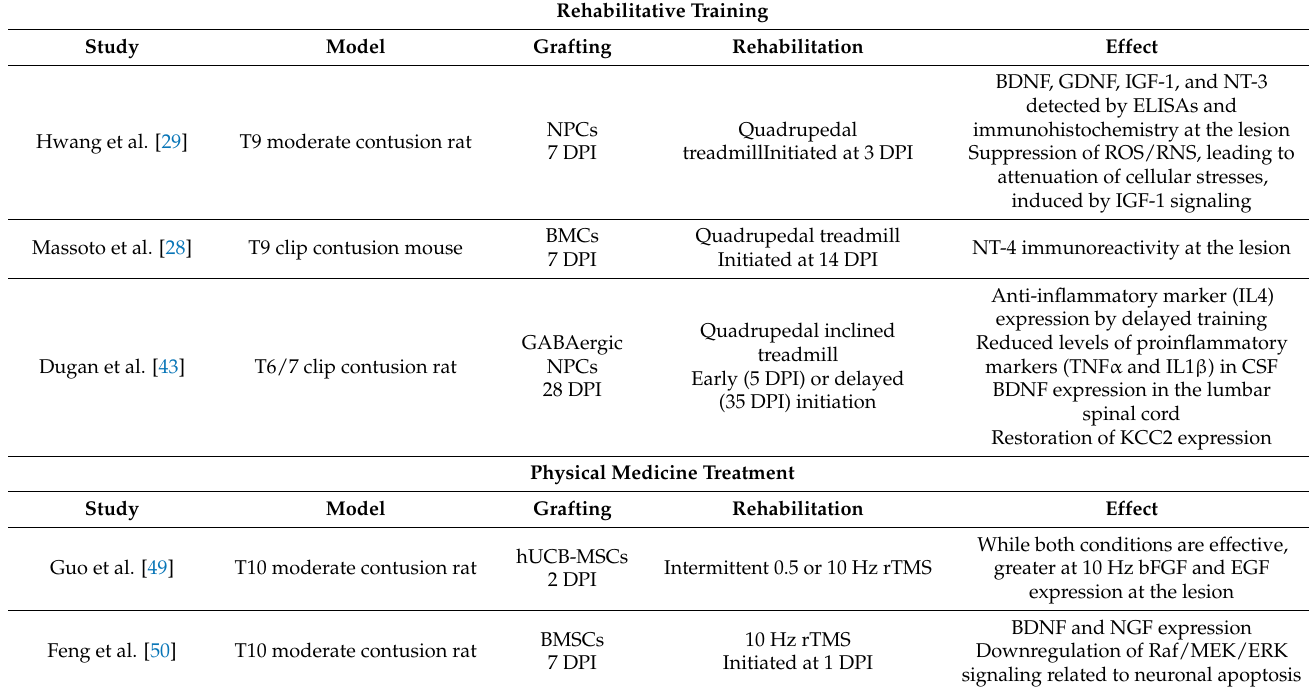
Table 4. Further mechanisms underlying the effects of regenerative